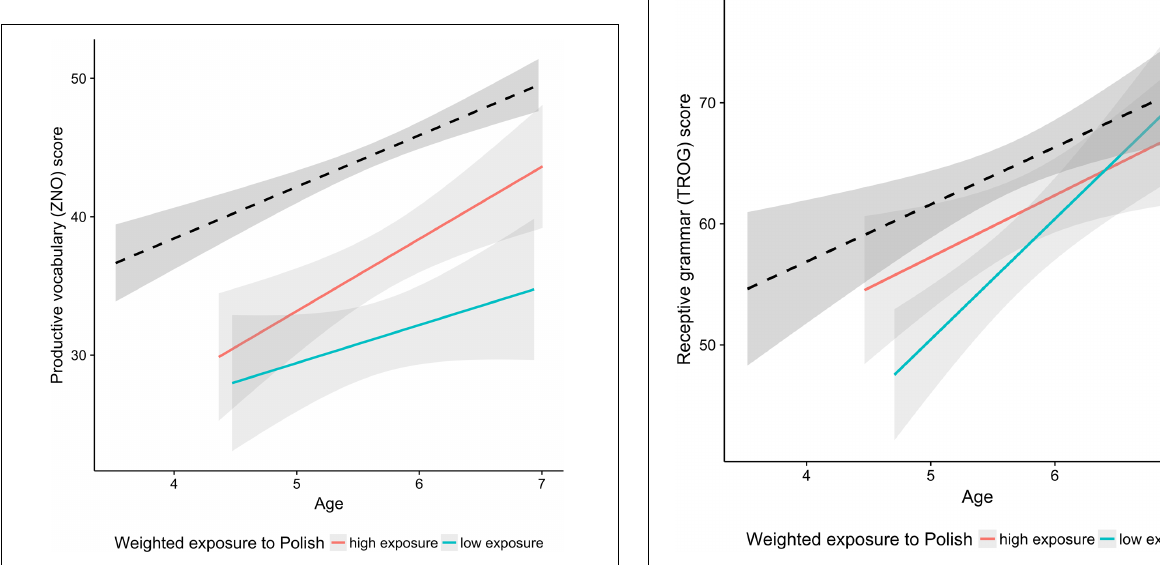
FIGURE 5 | Scores in the receptive grammar test plotted as a function of age. The black dashed line indicates the monolingual group and the two colored lines correspond to the bilingual group. Red and aqua correspond to the median split on exposure to L1 Polish. The median split was performed for visualization purpose